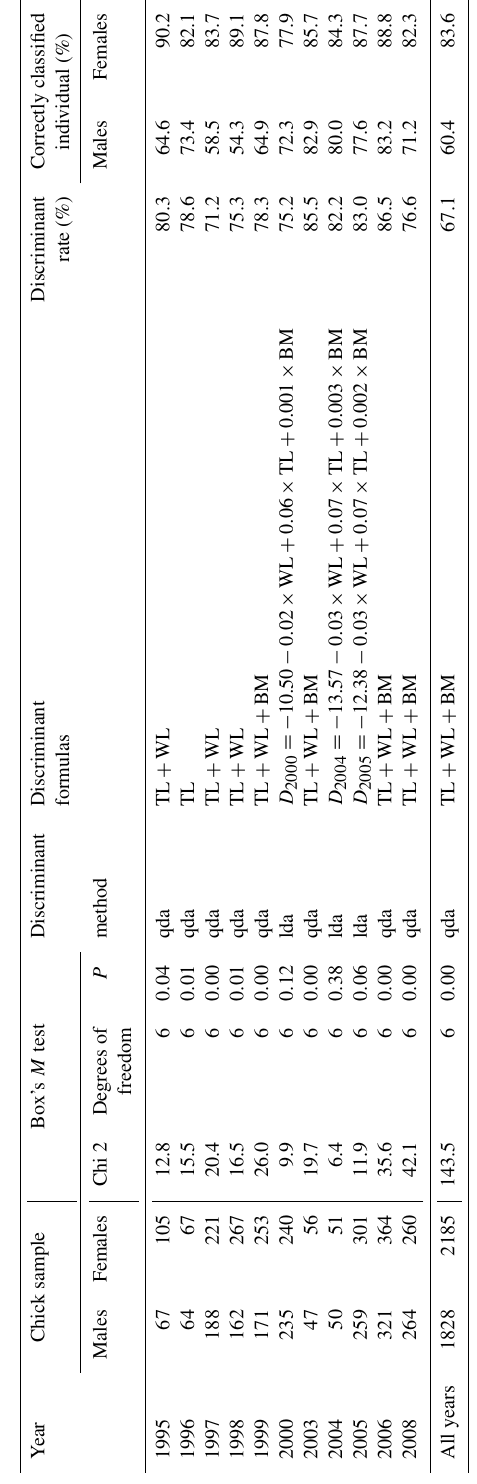
(males were larger than females ( t = 33 . 7, p < 0 . 000***)), and the mean difference index (MDI = 100 × mean fe- male/mean male; Delestrade, 2001; Helfenstein et al., 2004) was < 95 % for all characters (Table 2). Pooling all years, the largest difference occurred in body weight (males being 1.1 times heavier than females, Cohen’s d = 0 . 8). Dimor- phism in tarsus length was also important for all years (ratio male / female = 1 . 1, Cohen’s d = 0 . 9 and was less important for wing length (ratio male / female = 1 . 0, Cohen’s d = 0 .